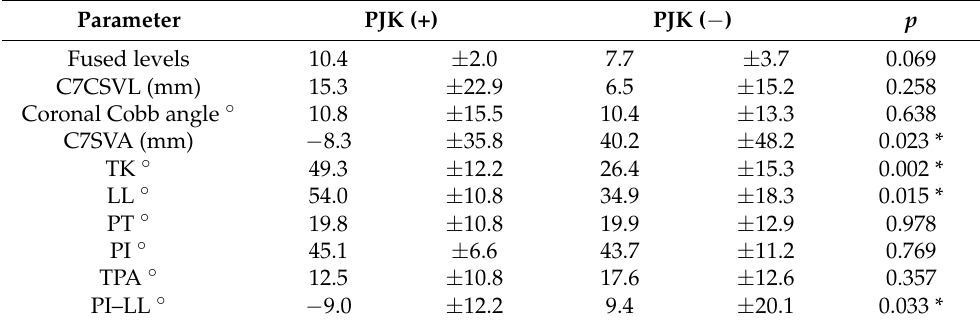
Table 3. Postoperative spinal parameters.